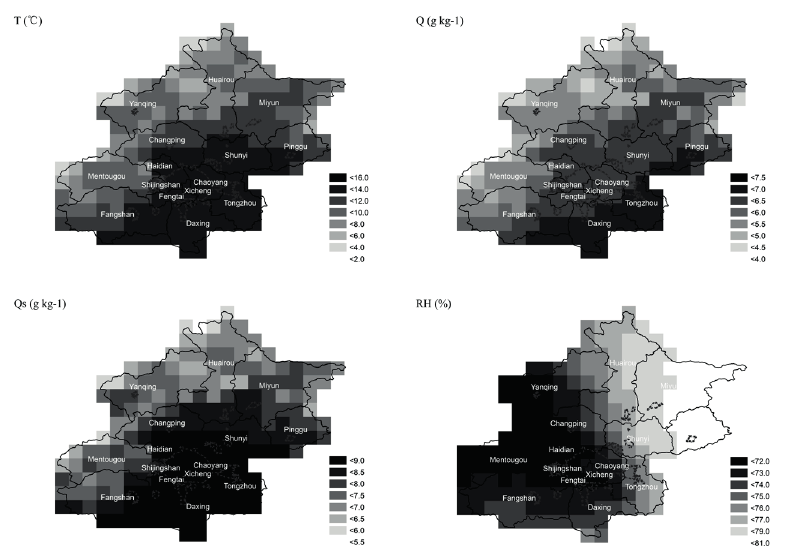
Fig. 4 Trends of surface humidity and temperature based on 3-hour gridded data during